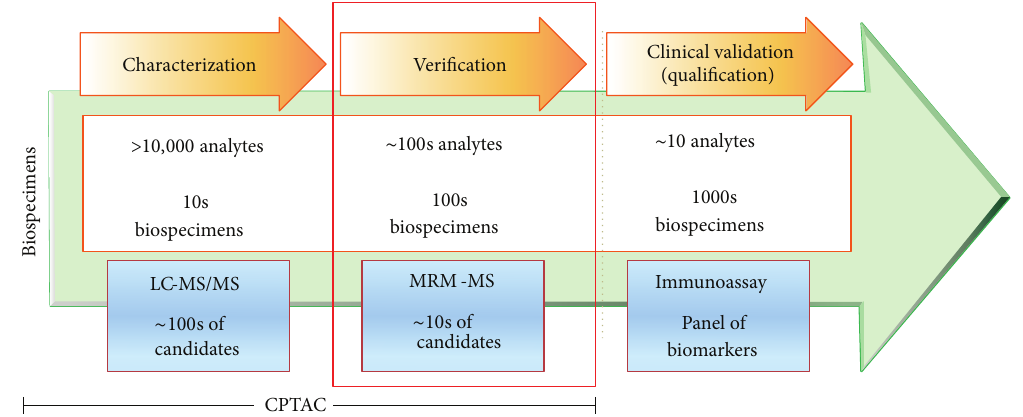
Figure 3: The incorporation of verification step into the NCI-CPTC pipeline bridging discovery and qualification.